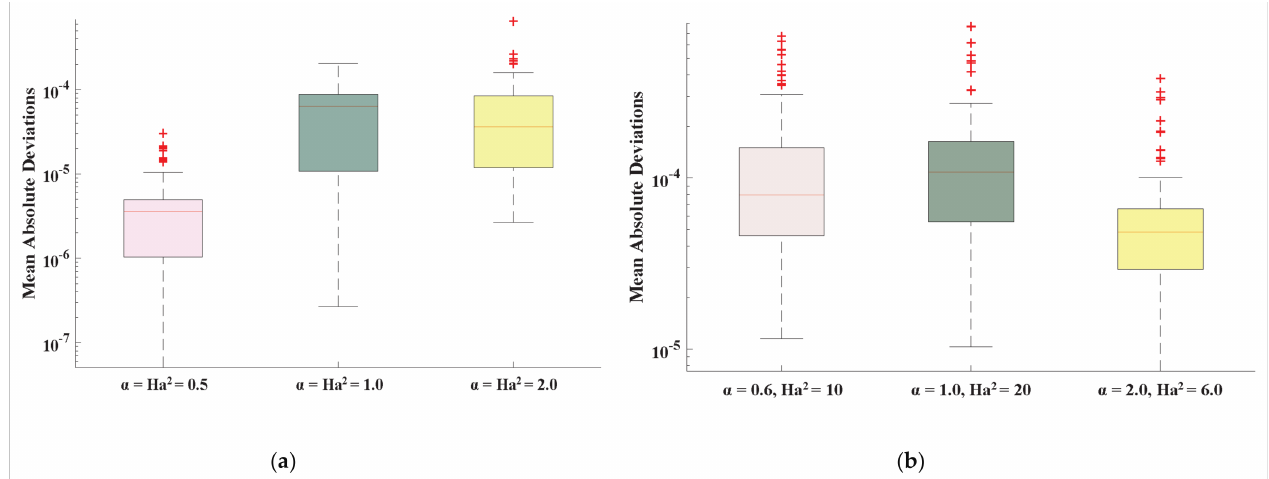
Figure 10. Boxplots for the analysis of the mean absolute deviation obtained by the design scheme during 100 independent runs for ( a ) same and ( b ) different values of nonlinearity parameter and Hartmann electric